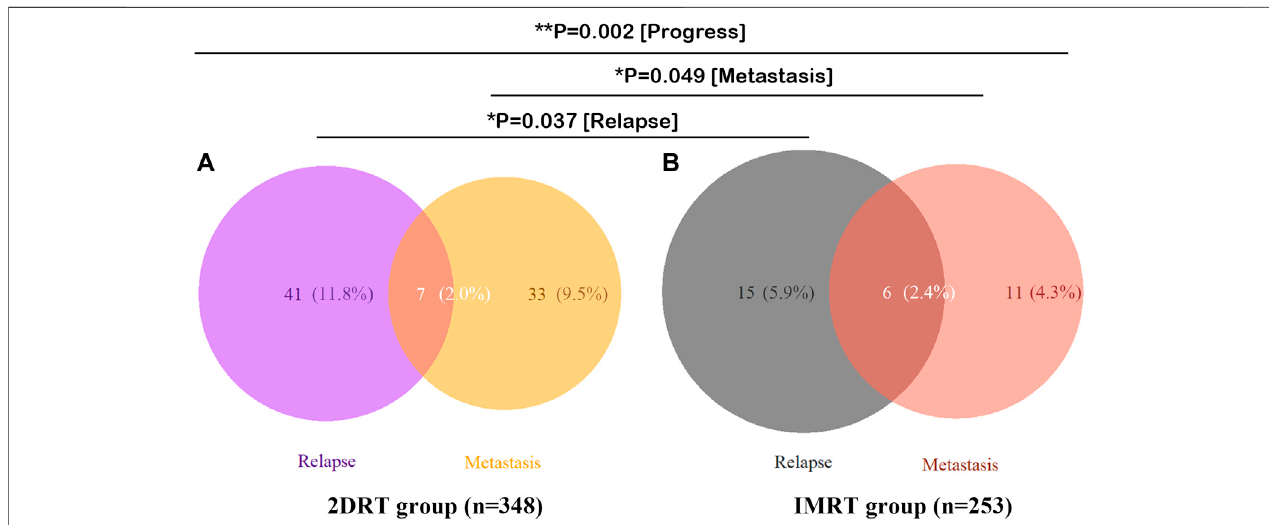
FIGURE1| Failurepatternsof601patientswithstageIINPC. (A) 2DRTsubgroup, (B) IMRTsubgroup.Abbreviation:2DRT (cid:1) two-dimensionalradiotherapy,IMRT (cid:1) intensity-modulated radiotherapy.